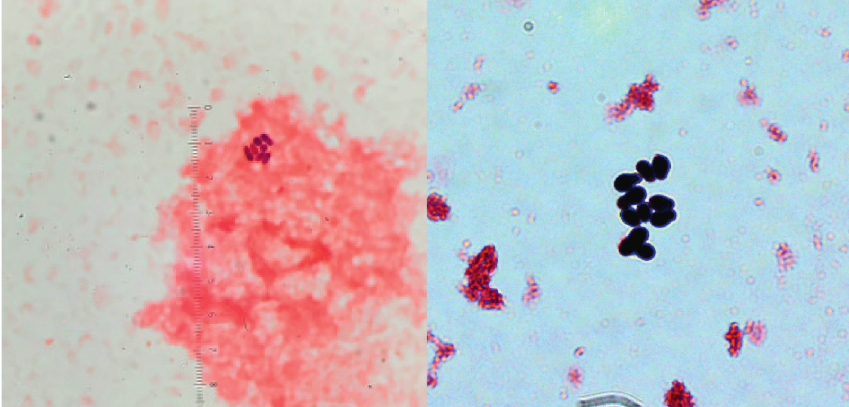
Figure 1: Gram-stained smear of positive blood culture revealing yeast-like cells with collarettes suspicious for a non- Candida organism, 40 x and 100 x .